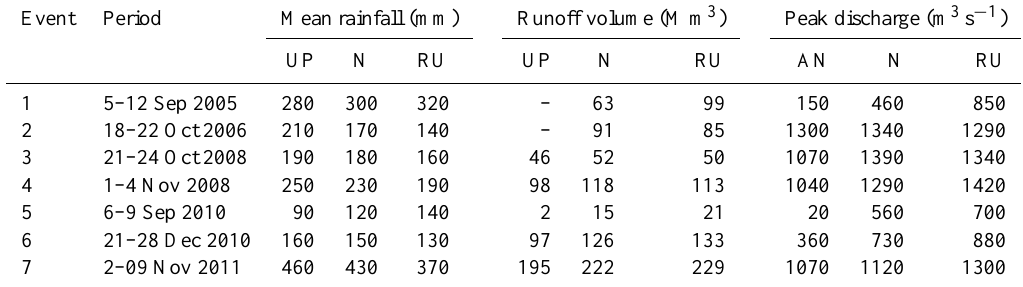
Table 2. Some key event characteristics. AN, N, and RU stand for the Anduze, Ners, and Russan stations. UP groups together both upstream sub-catchments (Anduze and Alès). The rating curve at the Alès station having been achieved after event nos. 1 and 2, volumes were not calculated in these two